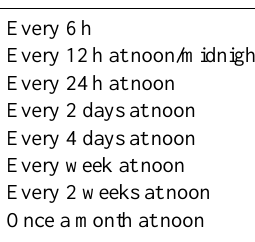
Table 1. List of applied sampling